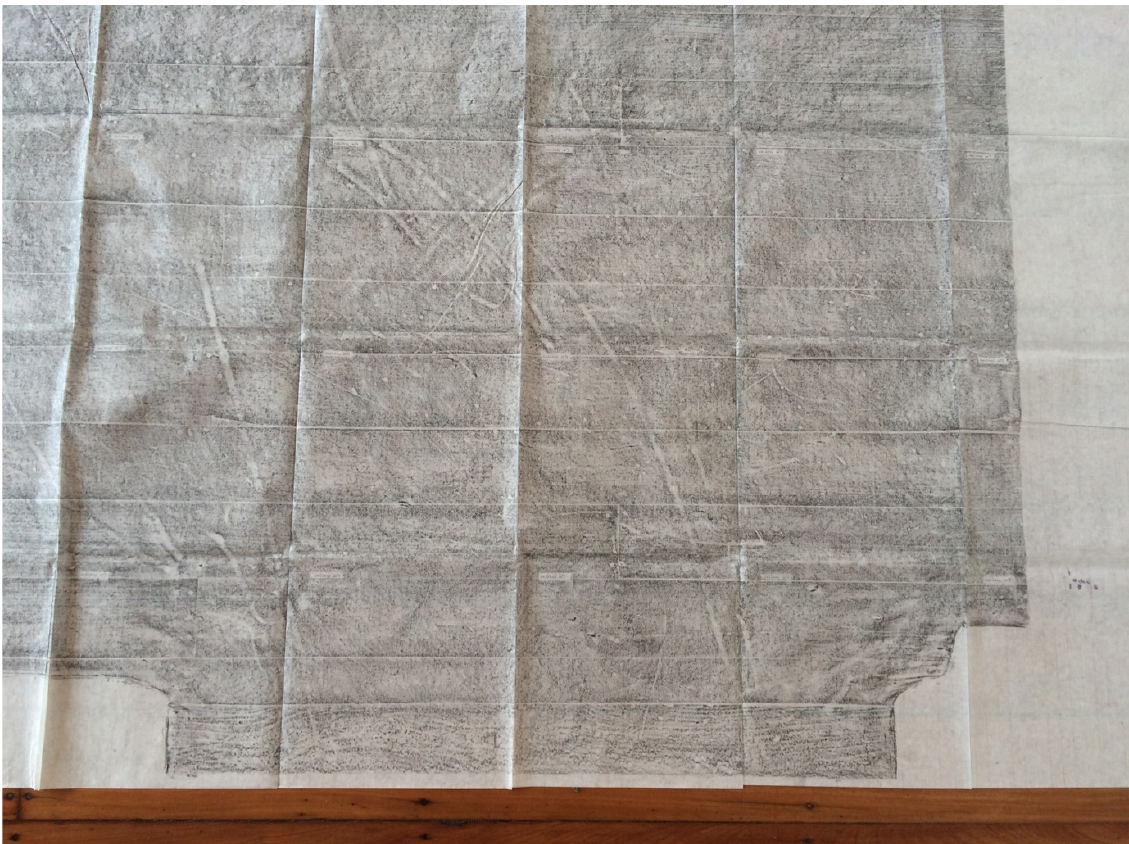
Figure 5. The floor we walk on , 2015. Enjoy Public Art Gallery, Te Whanganui-a-tara. Installation detail of Something Felt, Something Shared , curated by Emma Ng. Graphite on paper, dimensions variable. Collection of Chris Parkin.